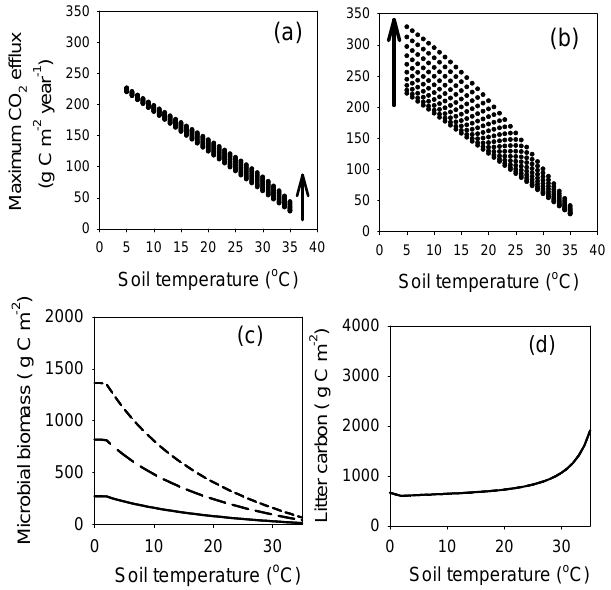
Figure 6. Dependence of maximum rate of CO 2 efflux from the decomposition of soil carbon in the primed treatment ( F max ) as a function of soil temperature and carbon addition at time t = 0 for model A (a) and B (b) . At each soil temperature, the carbon input was varied from 100 to 1000gCm − 2 , and F max increases with an increase in carbon input as shown by the arrow in each plot. (c) Vari- ation in equilibrium soil microbial biomass with soil temperature and carbon input at 200 (solid black line), 600 (long-dashed line), and 1000 (short-dashed line)gCm − 2 yr − 1 for model A. (d) Varia- tion in equilibrium litter carbon with soil temperature in model